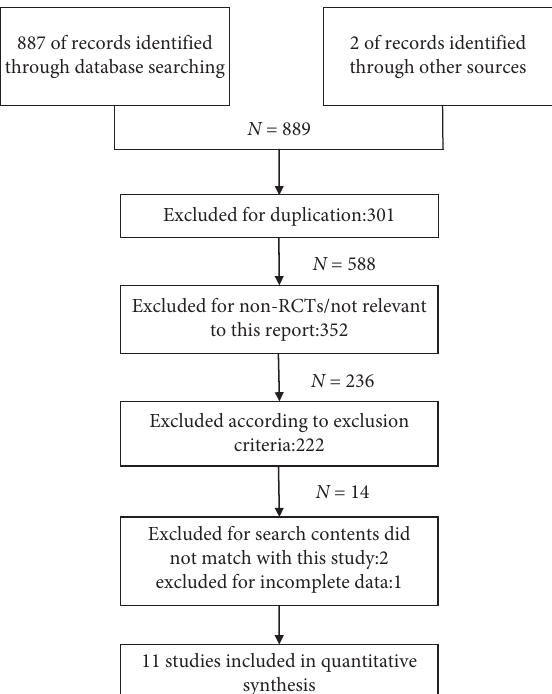
Figure 1: Flow chart of the literature search